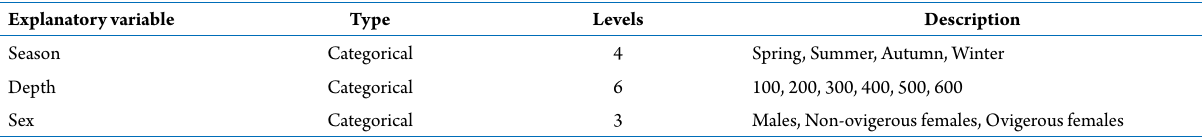
Figure 1. Sampling areas of Plesionika edwardsii in the mid-North Atlantic Ocean, Azorean region (ICES Subdivision 10a2) between 1999 and 2000. Orange dots represent each site sampled by a trap. Table 1. Explanatory variables hypothesized to affect catch rate and size composition of Plesionika edwardsii in the Azorean region during the period